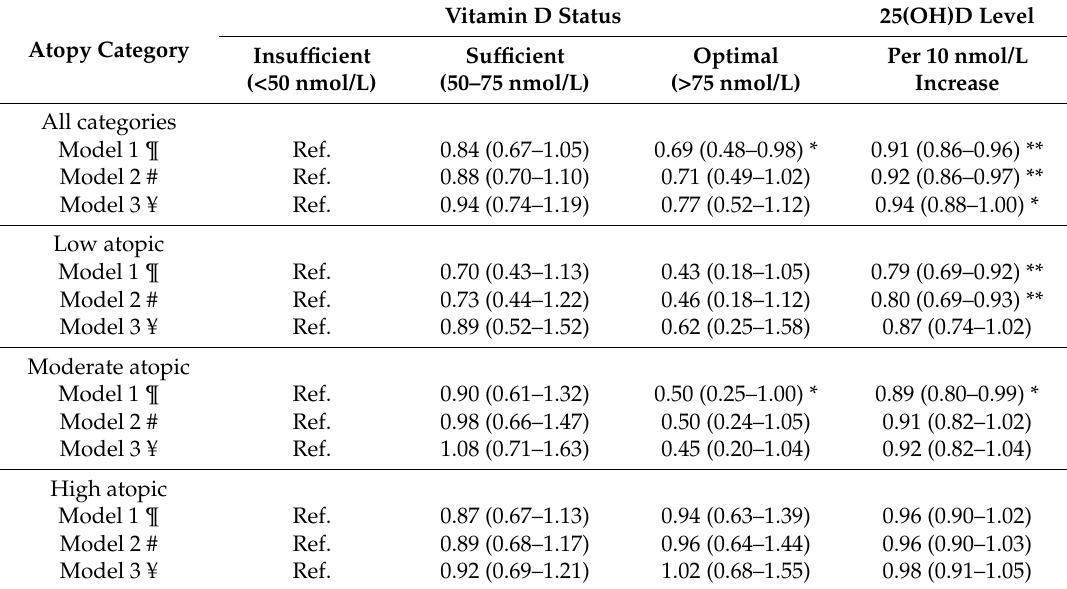
Table 2. Association between 25(OH)D levels and asthma at age 50, by atopic status